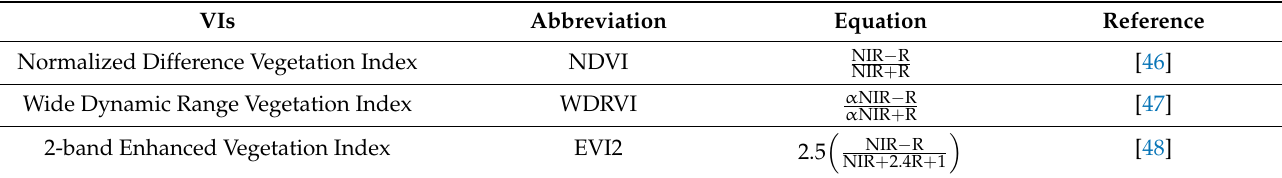
Table 3. Vegetation indices calculated for UAV orthomosaic images. VIs Abbreviation Equation